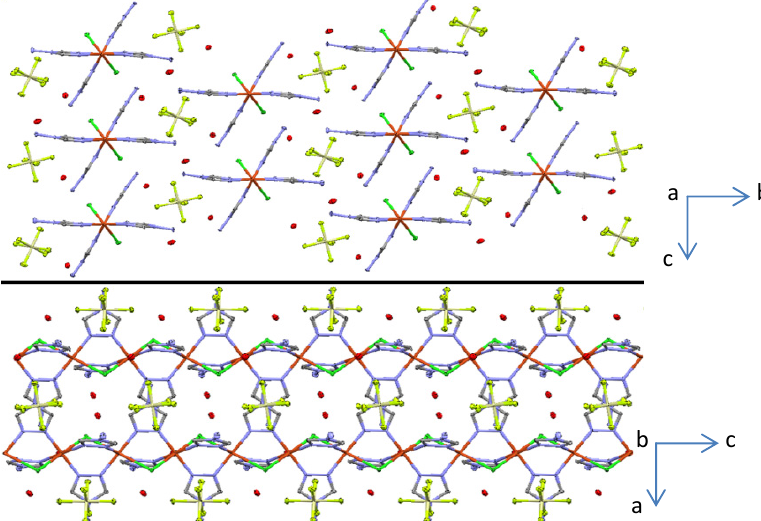
Figure 5. Thermal ellipsoid (50%) plot of IV along the a ( top ) and b ( bottom ) axes. The nitrogen atoms are depicted in blue, the carbon atoms in grey, the fluoride atoms in light green, the chloride ions in green, the copper atoms in red, the silicium atoms in yellow and the oxygen atoms are depicted in red. H-atoms were omitted for clarity.